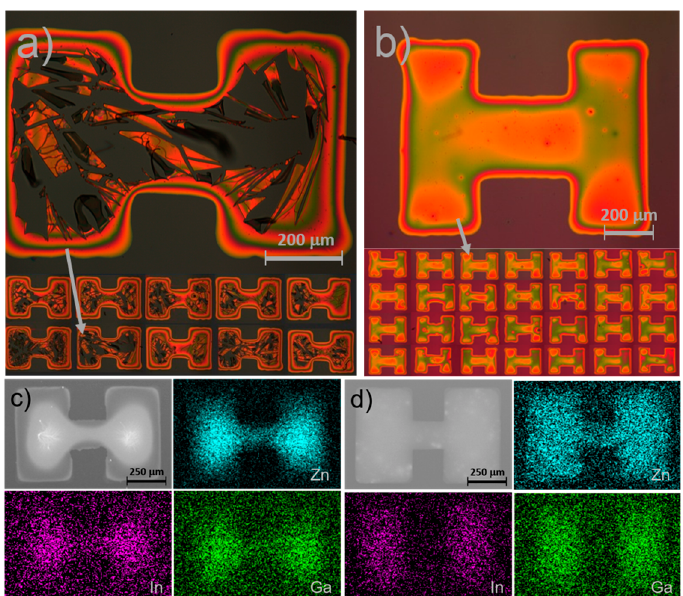
Figure 4. Microscope images of the patterned channel layer with traditional annealing ( a ) and a stepped annealing treatment ( b ). SEM images and EDS element mapping of the patterned channel layer with traditional annealing ( c ) and a stepped annealing treatment ( d ).